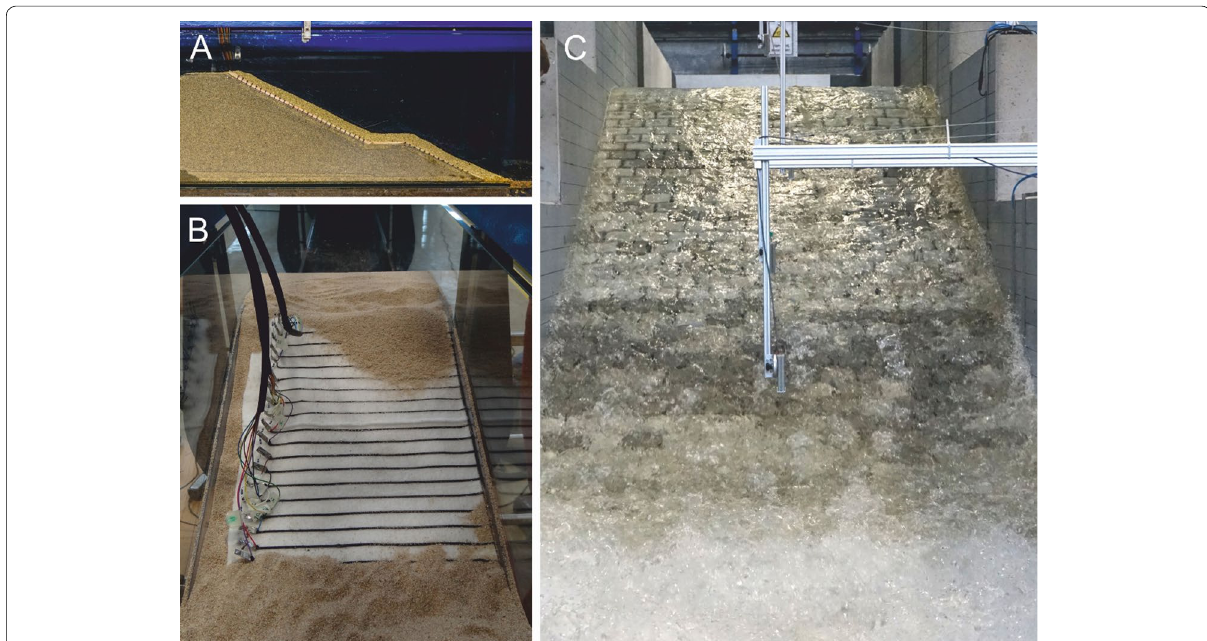
Fig. 6 Dike models used in project EarlyDike. A Small‑scale model, equipped with intelligent geotextile ( B ) for detection of water; C overflow of large‑scale dike